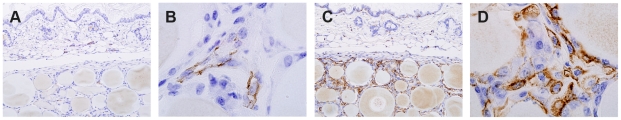
Immuno-histochemical analysis of BluePort-resident cells.Reactivity of antibodies to CD31, marker of endothelial cells, in (A and B), and to F4/80, marker of macrophages, in (C and D). Magnification 200x (A and C) and 1000x (B and D).